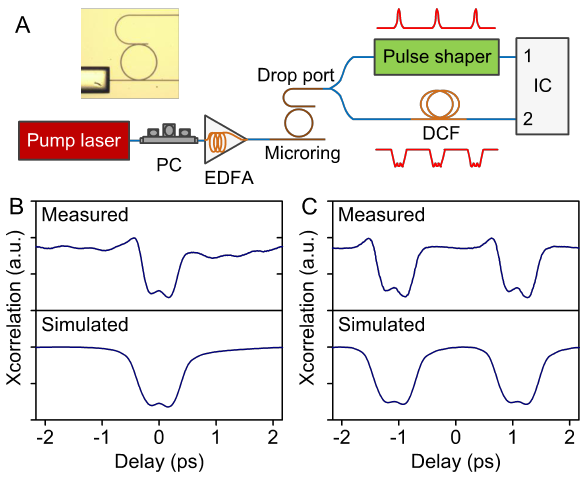
Figure 16: Time-domain characterization of dark pulse combs through spectral line-by-line shaping and self-referenced cross- correlation. (A) Experimental setup. The inset shows a microscope image of the Si 3 N 4 microring with both a through port (lower) and a drop port (upper). (B), (C) Cross-correlation results for the combs in Figures 15B III and 15E III, respectively. PC: polarization controller;